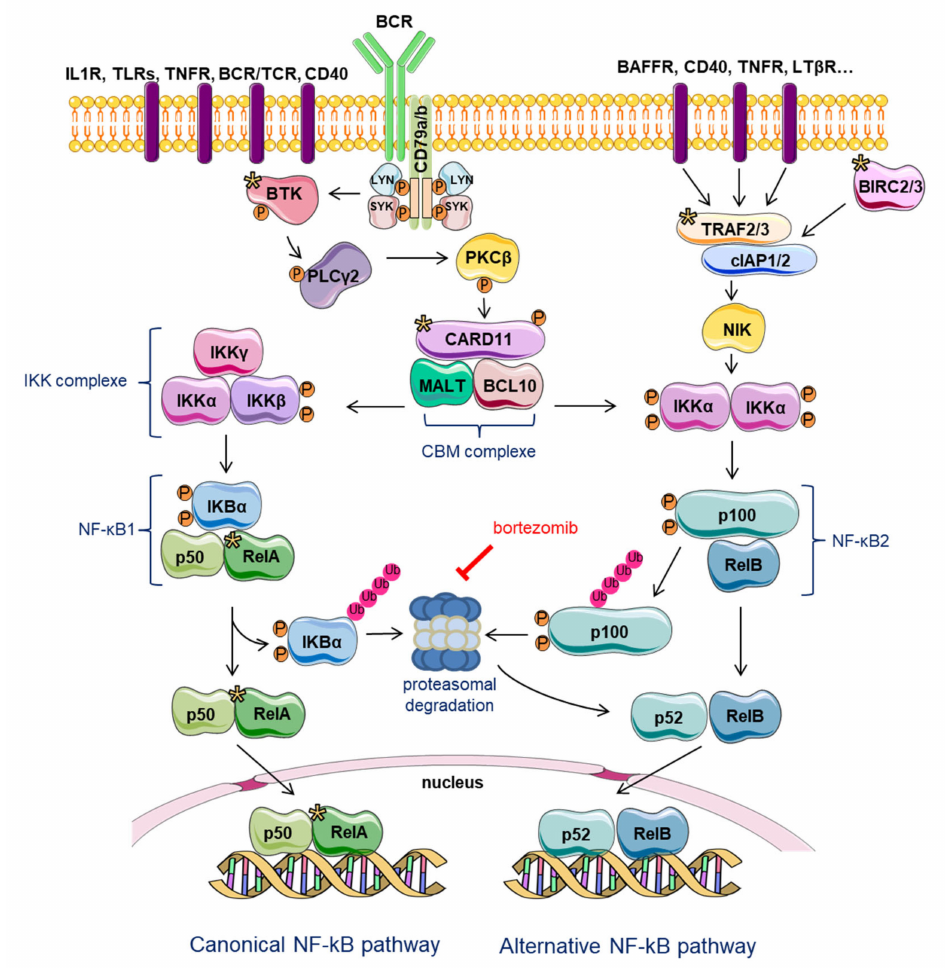
Figure 3. Canonical and alternative NF- κ B signaling pathways. Canonical pathway is triggered by toll-like receptors (TLRs), pro-inflammatory cytokines such as IL1 and TNF α receptor, and CD40. It relies on inducible degradation of I κ Bs, particularly I κ B α , leading to nuclear translocation of various NF- κ B complexes, predominantly the p50 / RelA dimer. Non-canonical NF- κ B pathway relies on phosphorylation-induced p100 processing, which is triggered by signals from a subset of tumor necrosis factor α (TNF α ) receptor (TNFR) members. This pathway is dependent on NF- κ B-inducing kinase (NIK) and I κ B kinase (IKK) α and mediates the activation of RelB / p52 complexes. Proteins potentially mutated in MCL are highlighted with a yellow